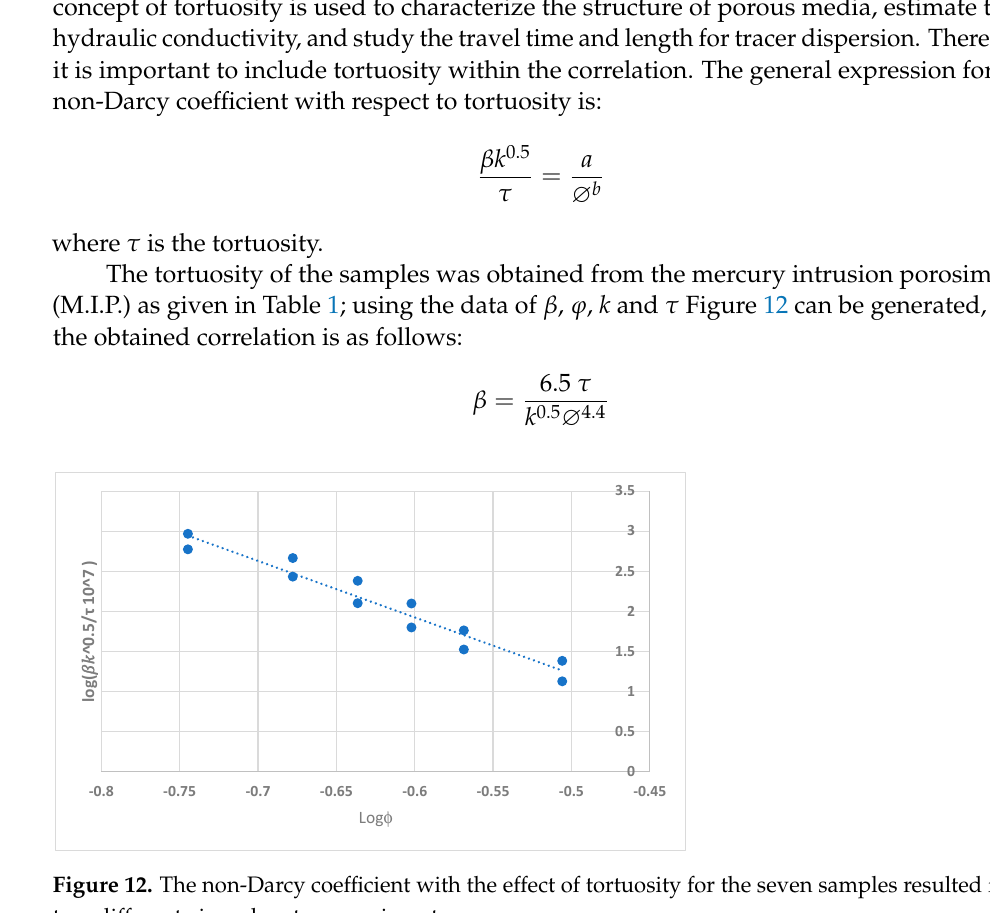
Figure 13. Comparison of correlation equation (23) with Geertsma and Tek correlations.